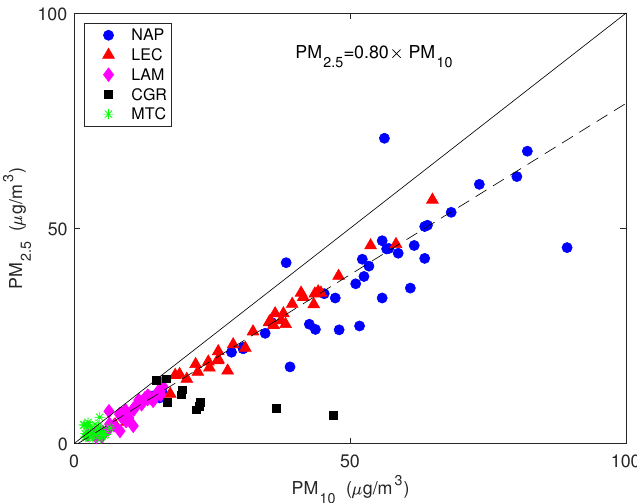
Figure 4. The values of the simultaneously measured PM 2.5 and PM 10 mass concentrations. The straight line is the 1:1 line and the dashed line is the robust linear fit.